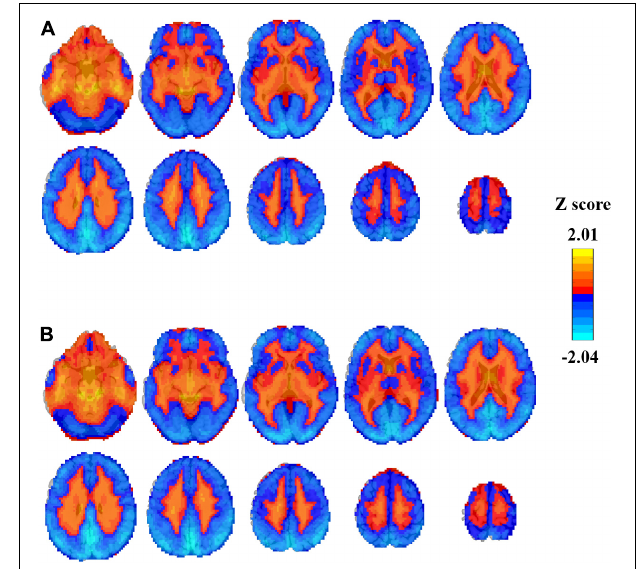
FIGURE 3 | Individual Z-transformed PSS (linear coefficient b) distribution in EC (A) and EO (B) conditions averaged across all subjects ( n =